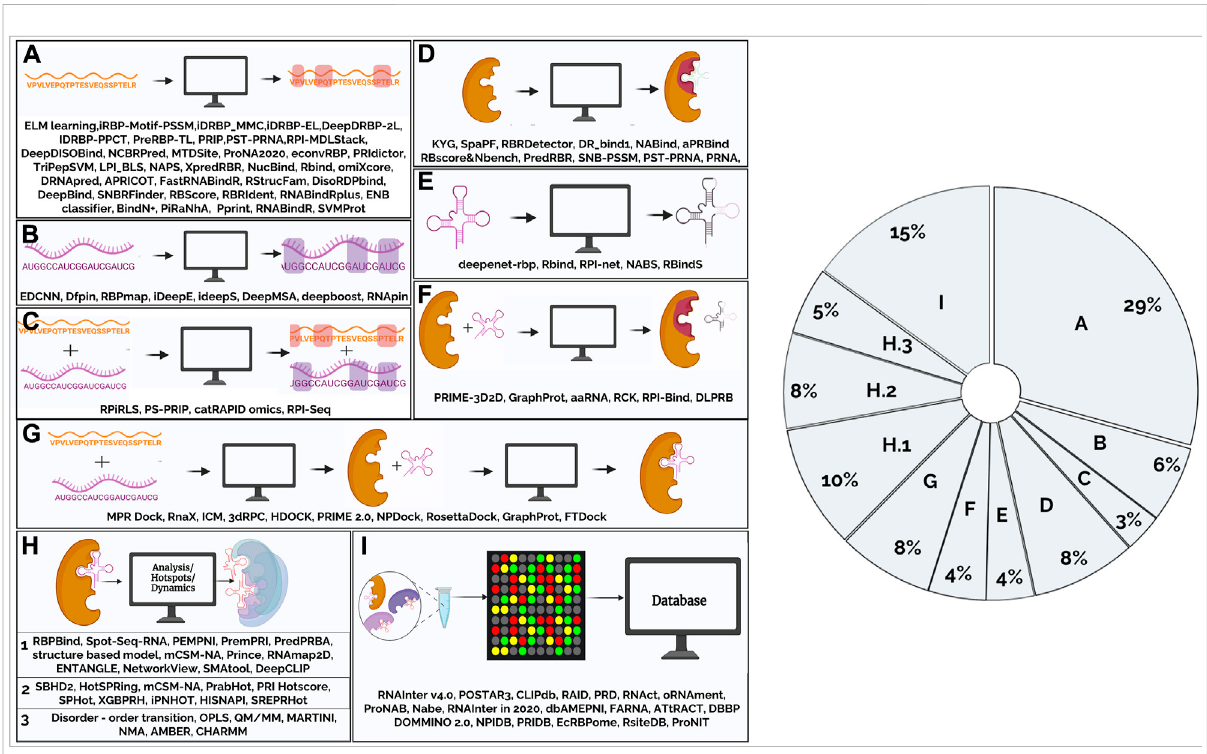
FIGURE 1 Figure summarizes the tools that are available to study protein-RNA interactions that have been classi fi ed based on their function. (A) . Computational tools for predicting amino acid residues in protein-RNA interactions using protein sequence (2.1.1) (B) . Computational tools for predicting nucleotides in protein-RNA interactions using RNA sequence (2.1.2) (C) . Computational tools for predicting amino acid residues and nucleotides in protein-RNA interactions using sequence information. (2.1.3) (D) . Computational tools for predicting amino acid residues in protein-RNA interactions using protein structural information (2.2.1) (E) . Computational tools for predicting nucleotides in protein-RNA interactions using RNA structural information (2.2.2) (F) . Computational tools for predicting amino acid residues and nucleotides in protein-RNA interactions usingprotein,RNAstructuralandsequenceinformation(2.2.3) (G) .Computationaltoolsformodelling/dockingofprotein-RNAcomplexes(2.3) (H) .1. Computational tools for analysis of protein-RNA complexes (2.4) (H) .2 Computational tools for prediction of hotspots in protein-RNA complexes